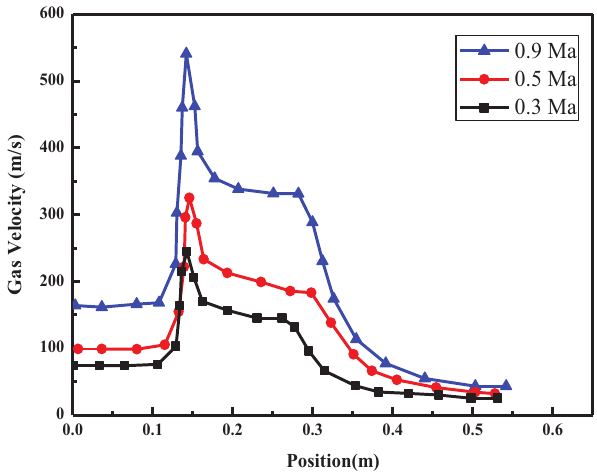
Figure 8: Plot of gas velocity at Mach 0.3 – Mach